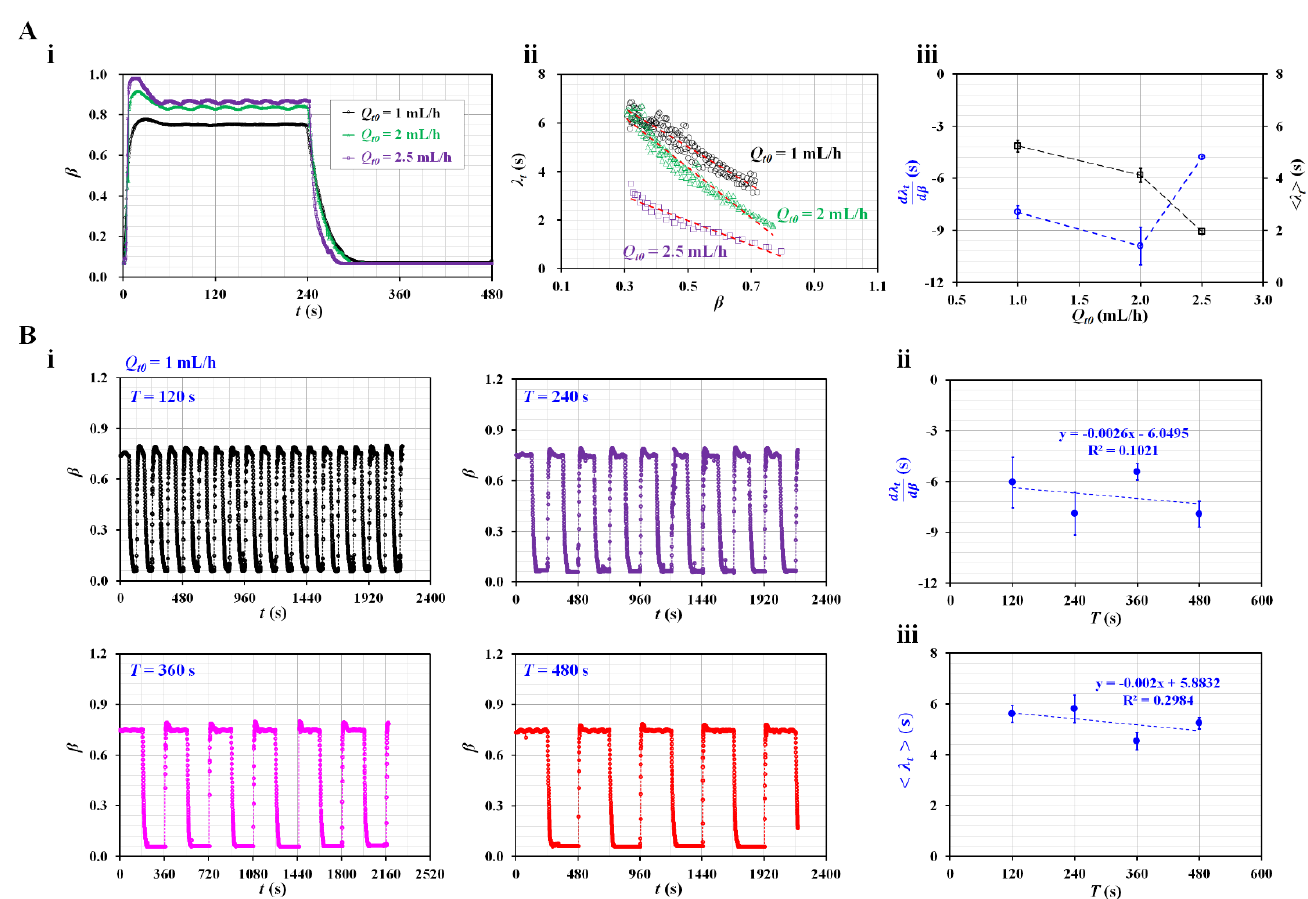
Figure 3. Contributions of flow rate condition of the test fluid (i.e., maximum flow rate and period) to the time constant. ( A ) Effect of the amplitude ( Q t 0 ) of the flow rate of the test fluid. The period was fixed at T = 480 s. ( i ) Temporal variations in β with respect to Q t0 = 1, 2, and 2.5 mL/h. ( ii ) Variations in λ t with respect to β and Q t 0 . ( iii ) Variations in 𝑑𝜆 𝑡 𝑑𝛽 and < λ t > with respect to Q t 0 . ( B ) Contribution of the period of the flow rate of the test fluid to the time constant. The amplitude of the flow rate of the test fluid was fixed at Q t 0 = 1 mL/h. ( i ) Temporal variations in β with respect to T = 120, 240, 360, and 480 s. ( ii ) Variations in 𝑑𝜆 𝑡 with respect to T . ( iii ) Variations in < λ t > with respect to T . 𝑑𝛽